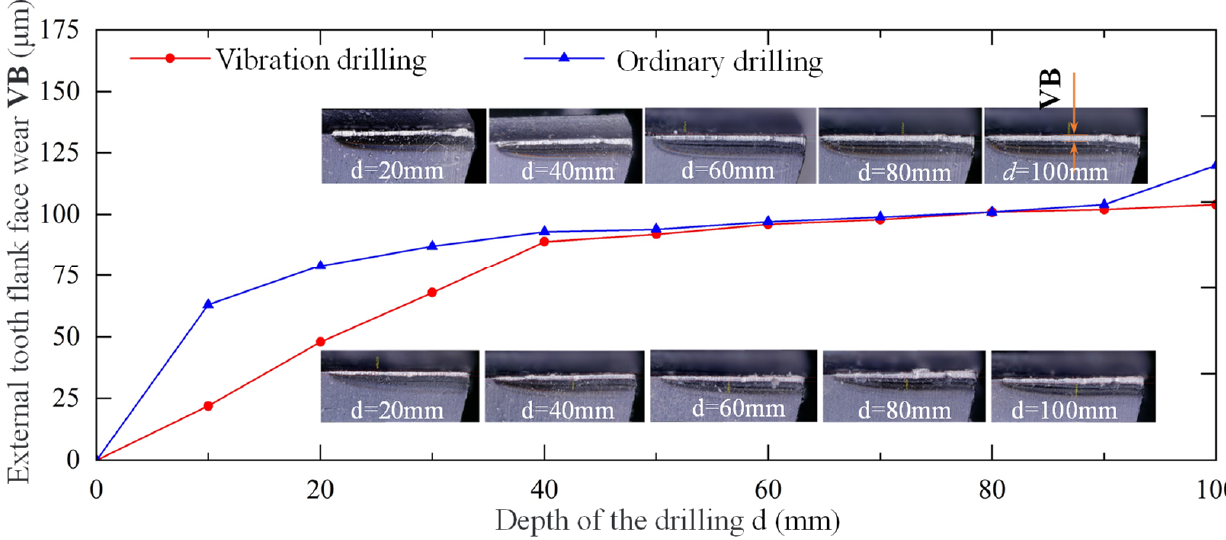
Figure 10. Variation of the wear width VB of the of the external teeth flank face with the same drilling depths between two drilling methods.